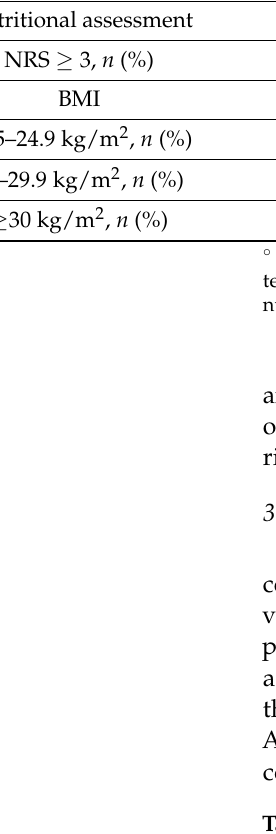
Table 2. Spearman’s rank correlation among micronutrient